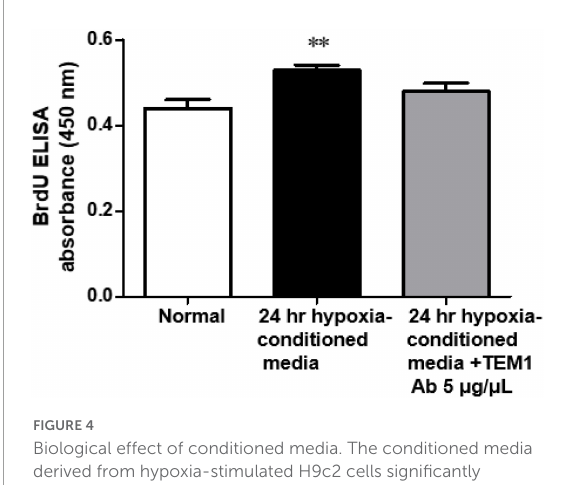
FIGURE4 Biological effect of conditioned media. The conditioned media derived from hypoxia-stimulated H9c2 cells significantly increased the cell proliferation of cardiac fibroblasts and this effect was partially reduced with anti-TEM1 antibody n = 4. ∗∗ p < 0.01 compared to normal without adding conditioned